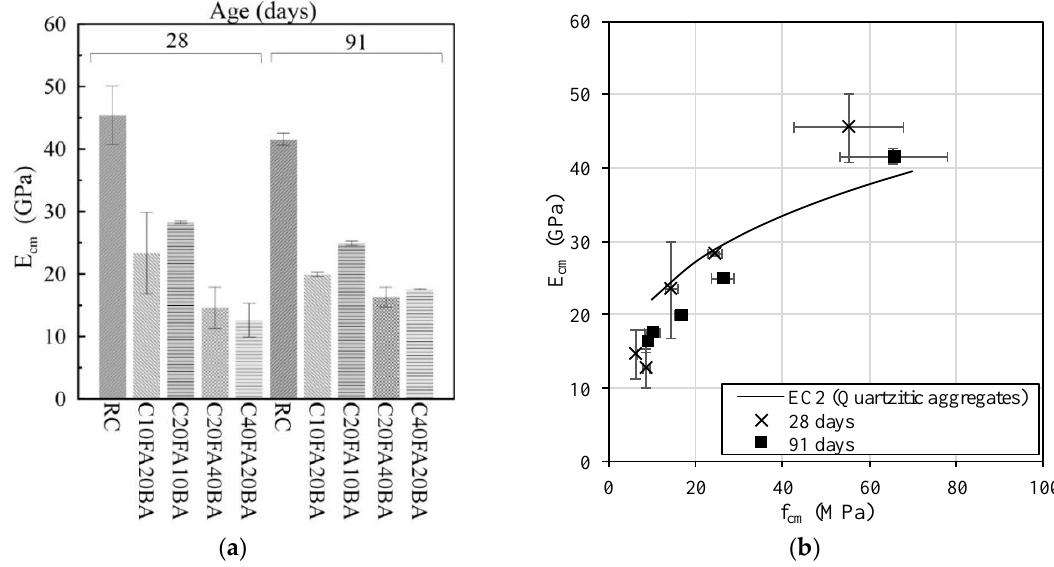
Figure 7. Modulus of elasticity (E cm ) at 28 days ( a ); relationship between E cm and f cm at 28 and 91 days ( b ).